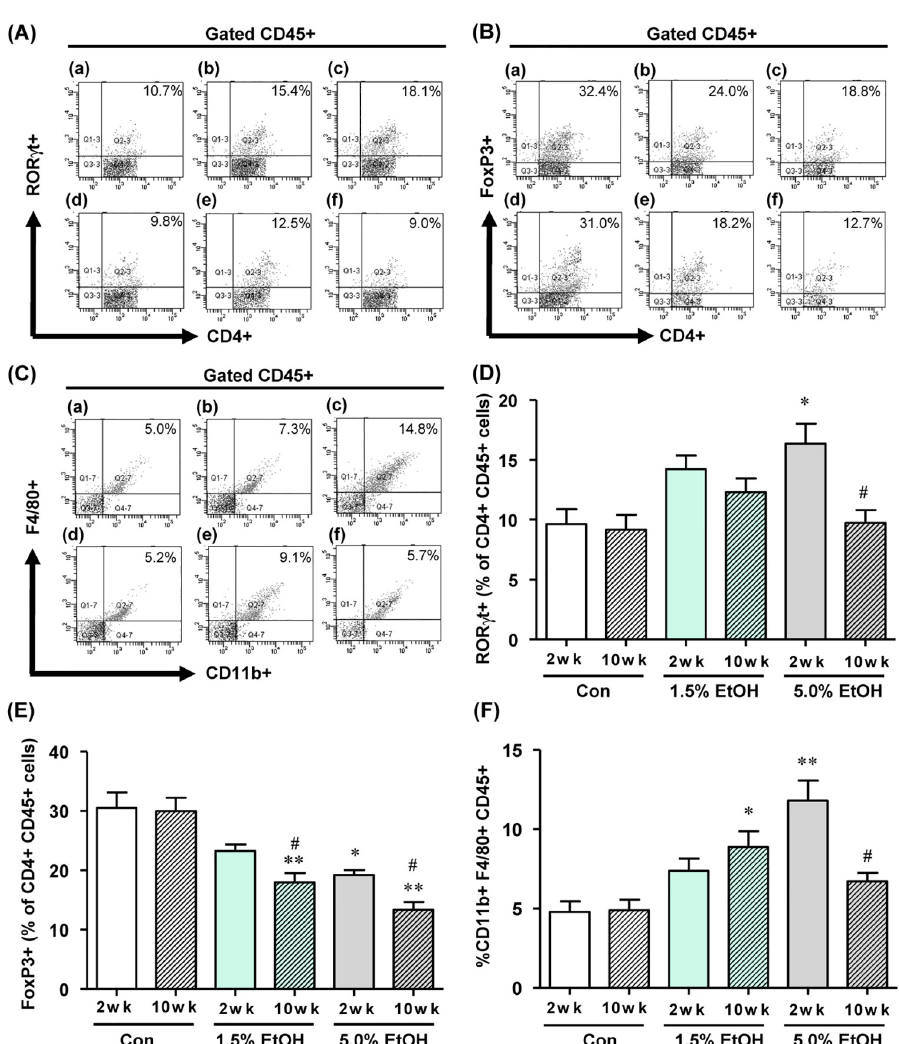
Fig 5. Effects of chronic oral administration of ethanol on the colonic population of inflammation-associated immune cells in mice as analyzed by flow cytometry. (A) The proportion of CD4 + CD45 + ROR γ t + T cells, (B) CD4 + CD45 + Fox3 + T cells, (C) CD11b + CD45 + F4/80 + macrophages detected by flow cytometry: (a) 2-wk Con, (b) 2-wk 1.5% EtOH, (c) 2-wk 5.0% EtOH, (d) 10-wk Con, (e) 10-wk 1.5% EtOH, (f) 10-wk 5.0% EtOH. The quantitative analyses data are shown: (D) CD4 + CD45 + ROR γ t + T cells, (E) CD4 + CD45 + Fox3 + T cells, (F) CD11b + CD45 + F4/80 + macrophages by flow cytometry. For (D), (E) and (F), the results are expressed as means ± SD (n = 4). � p < 0.05, �� p < 0.01 and versus 2 wk control, as assessed by ANOVA with the Tukey-Kramer test. # p < 0.05 for 2 wk versus 10 wk with the same ethanol dosage, as assessed by the paired t -test. For abbreviations for ethanol-administration conditions, see the legend to Fig 2. For experimental details, see Materials and methods. were Firmicutes , Bacteroidetes , and Deferribacteres (Fig 8A). Although the same phyla were found at week 5 in feces of the 1.5%-ethanol and 5.0%-ethanol groups, Firmicutes formed a sig- nificantly smaller proportion in the 1.5%-ethanol group than in control mice, whereas Deferri- bacteres formed a significantly smaller proportion in the 1.5%-ethanol and 5.0%-ethanol groups than in control mice (Fig 8B). The relative abundances of Bacteroidetes and Proteobac- teria were significantly increased at week 5 feces of 1.5%-ethanol and the 5.0%-ethanol groups, respectively.